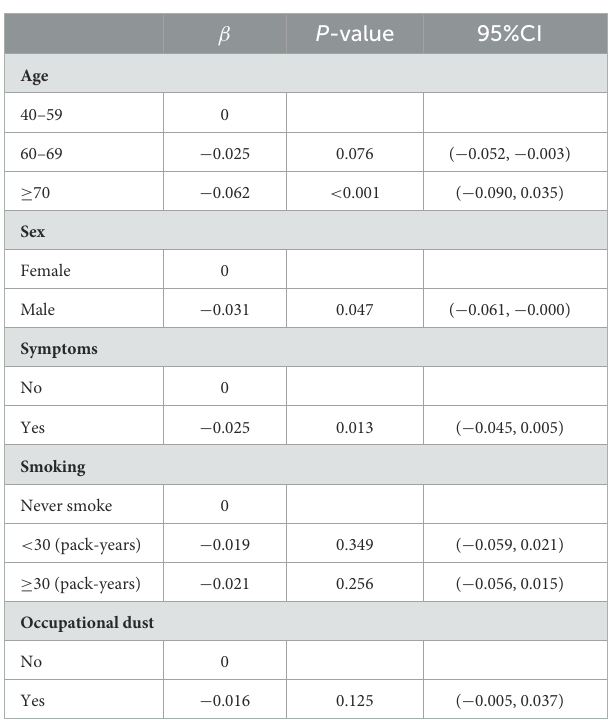
TABLE 6 A generalized linear model of FEV 1